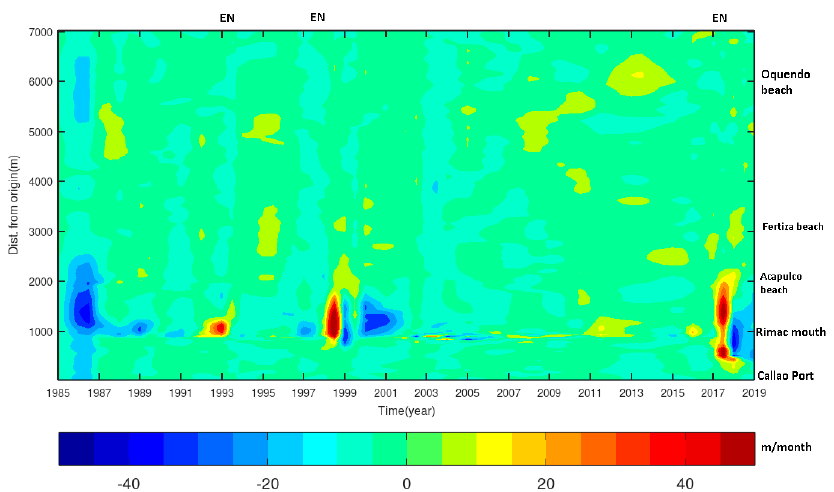
Figure 12. Temporal and space evolution of the Callao Bay shoreline. Figure shows shoreline variations in time and space, indicating EN events.